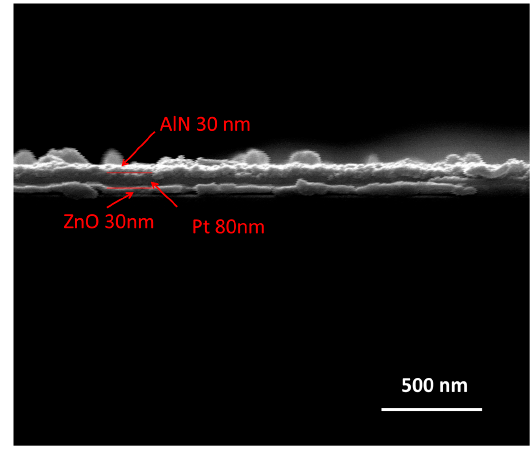
Figure 4. SEM image of the cross-section of the AlN/Pt/ZnO(RT)/LGS sample.